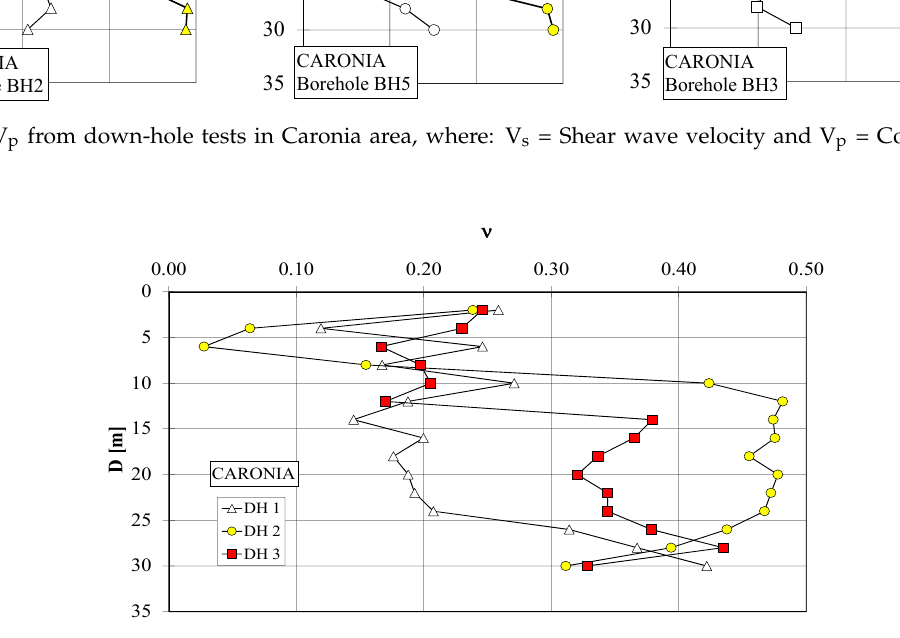
Figure 8. Poisson ratio from down-hole tests.